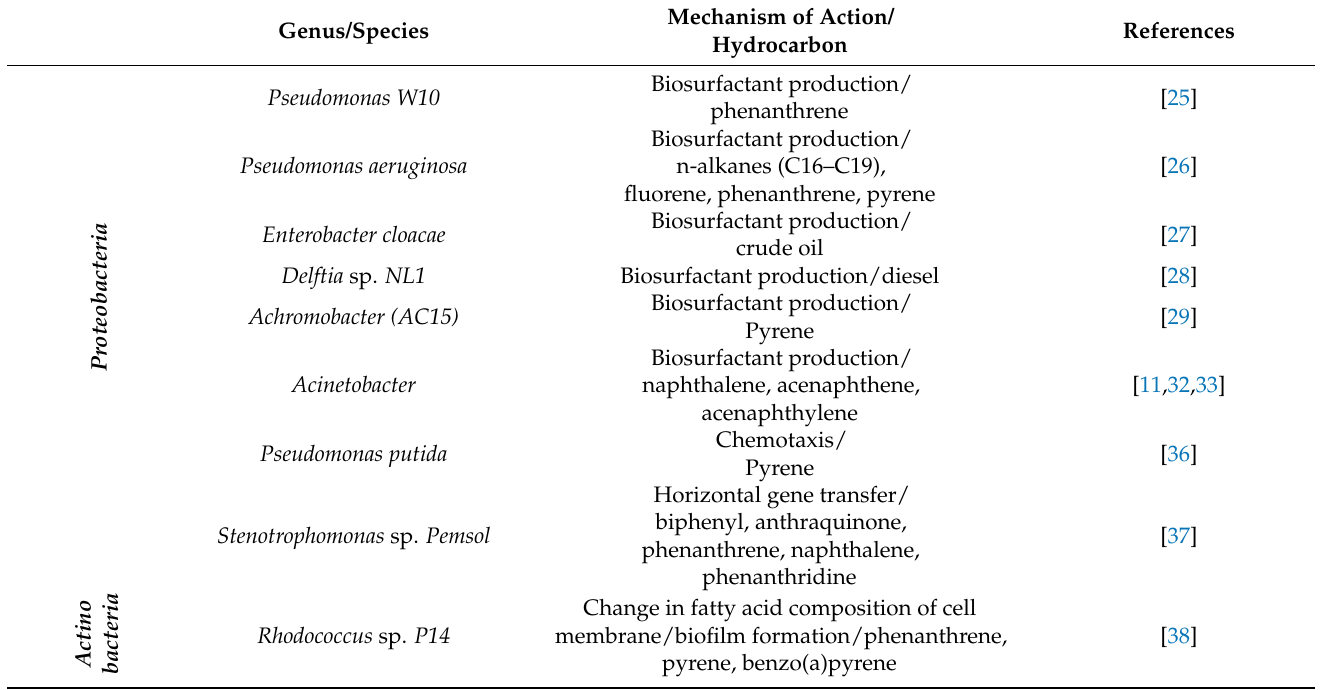
Table 2. Example of single bacteria involved in hydrocarbon